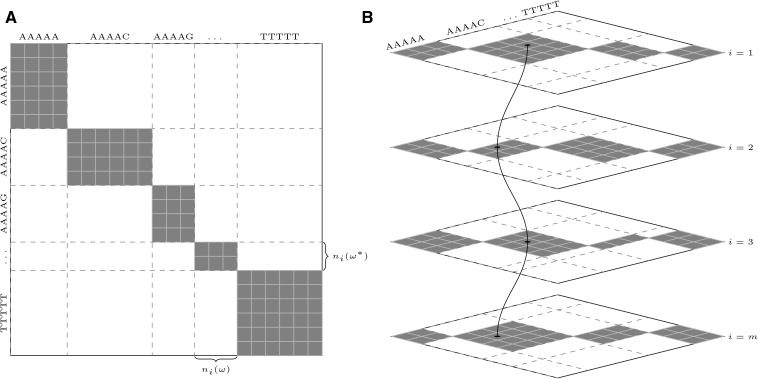
(A) A diagram exemplifying the helix space. Horizontal and vertical axes correspond to the hash tables Hi and Hi*, respectively; widths and heights of the gray rectangles are ni(ω) and ni(ω*), respectively. The total gray area represents the number of (ordered) pairwise combinations of complementary k-mers. (B) Several diagrams as in A need to be parsed simultaneously in order to find conserved complementary k-mers. Pairs equivalent under ≃ are connected by a path.